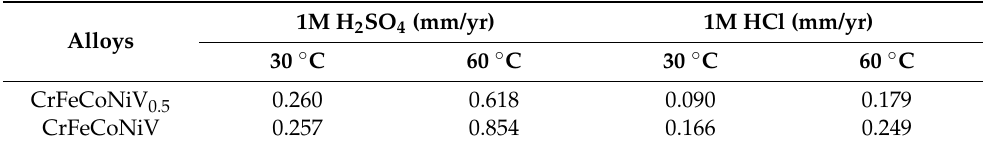
listed in Table 7. The results indicated that the corrosion resistance of the CrFeCoNiV 0.5 alloy was better than that of the CrFeCoNiV alloy in both the deaerated 1M H 2 SO 4 and 1M HCl solutions. The CrFeCoNiV 0.5 alloy has a granular structure, and grain boundaries in the alloy were easily to be corroded because of higher Gibbs free energy, as shown in Figure 8a. CrFeCoNiV alloy has a dual-phased dendritic structure; these two phases would form the cathode and anode of local cells in the CrFeCoNiV alloy. Therefore, the corrosion rate of CrFeCoNiV alloy was larger than that of CrFeCoNiV 0.5 alloy in these two solutions. In addition, increasing the test temperature increased the corrosion rates of the CrFeCoNiV x alloys. However, the results also indicated that the corrosion resistance of the CrFeCoNiV x alloys in deaerated 1M HCl solution was better than that in 1M H 2 SO 4 solution. Table 7. Corrosion rates of the as-cast CrFeCoNiV x alloys in deaerated 1M H 2 SO 4 and 1M HCl solutions. 1M H 2 SO 4 (mm/yr) 1M HCl (mm/yr) Alloys 30 ◦